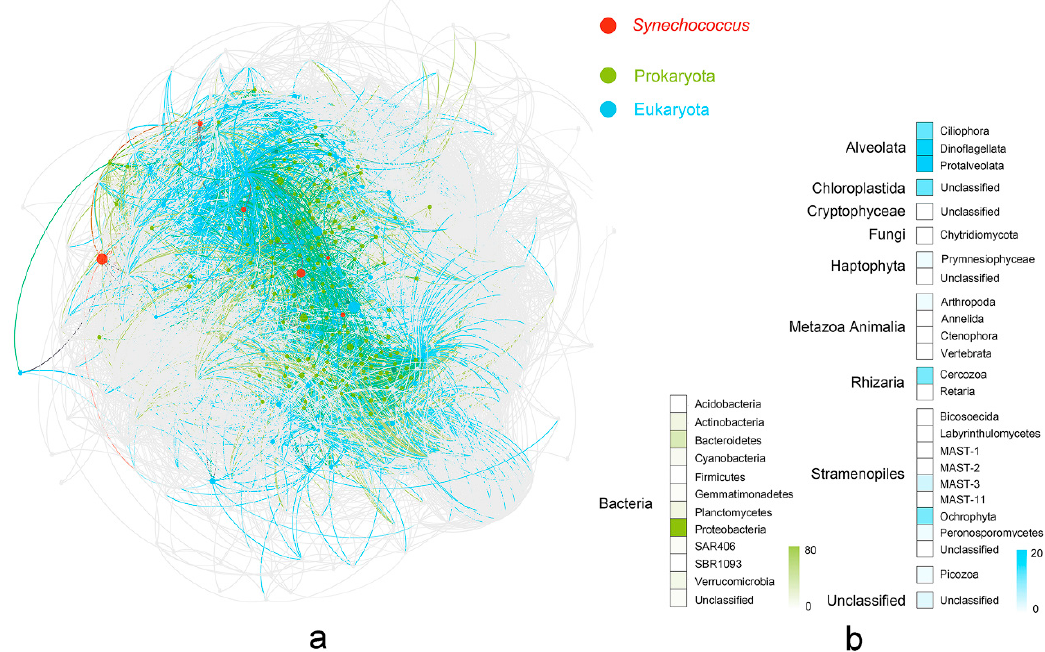
Figure 5. Microbial community co-occurrence network associated with Synechococcus . ( a ) The network of microbial community relationships encompassing all prokaryotic and eukaryotic OTUs was constructed from the correlation matrix using a force-directed layout algorithm; red nodes represent six OTUs belong to Synechococcus ; gray nodes represent OTUs with the absolute value of Spearman coefficients < 0.6 and p > 0.05 with Synechococcus ; green nodes represent prokaryotic OTUs with the absolute value of Spearman coefficients > 0.6 and p < 0.05 with Synechococcus ; blue nodes represent eukaryotic OTUs with the absolute value of Spearman coefficients > 0.6 and p < 0.05 with Synechococcus . ( b ) Heatmap showing the number of predominant kingdoms/phyla associated with Synechococcus using color legend; two domains were represented with different colors (prokaryota: green; eukaryota: blue).